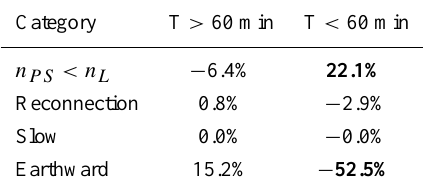
Table 4. Relative differences from expected values with respect to T from magnetosheath: earthward flows are more likely to be found in the centre of the magnetotail and flows with n PS < n L are more likely to be found close to the magnetopause Category T > 60 min